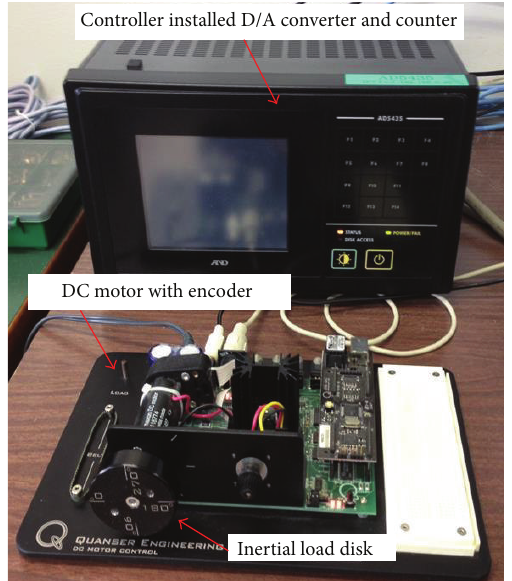
Figure 6: The picture of the control system.